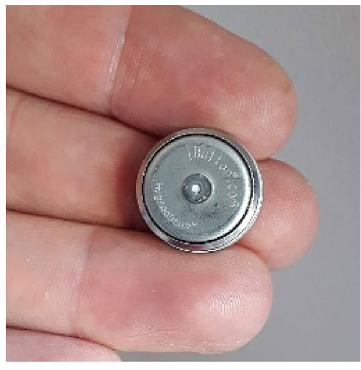
Figure 4. iButton wireless temperature and humidity recorder.